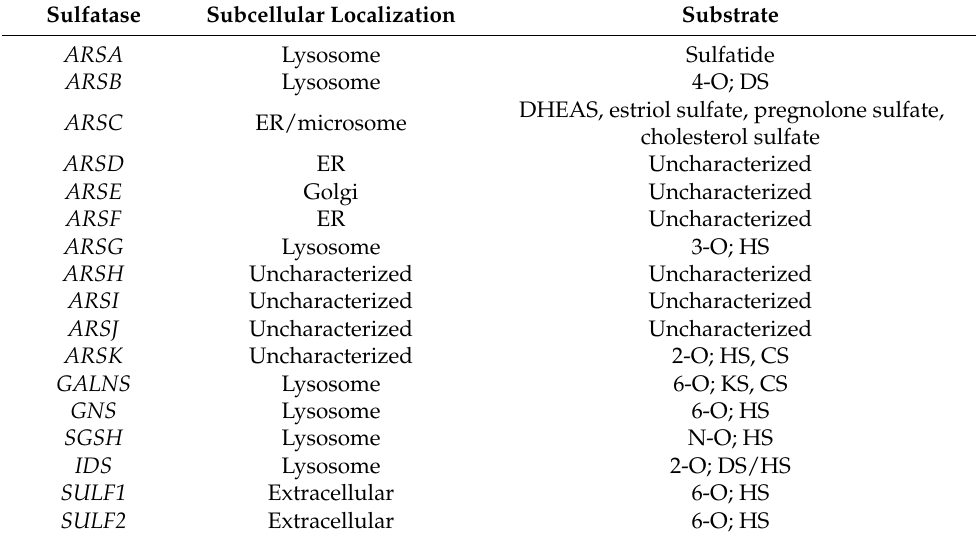
Table 2. Subcellular localization and substrate of